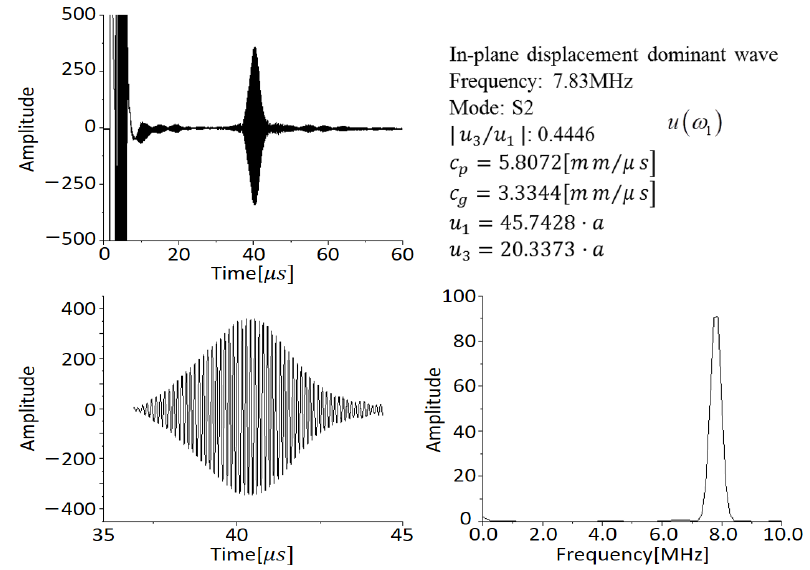
Figure 9. Wave velocity and frequency analysis for 7.83 MHz (S2 mode).